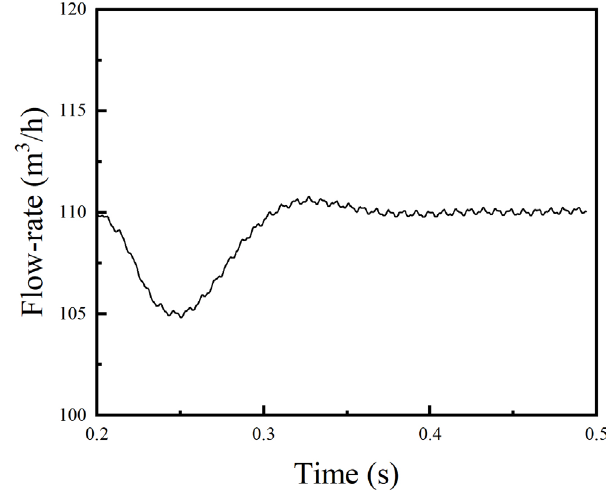
Fig. 13. Curve of impeller torque changing with rotation angle (centrifugal pump speed is 2955 r/min, fl ow rate is 110 m 3 /h).